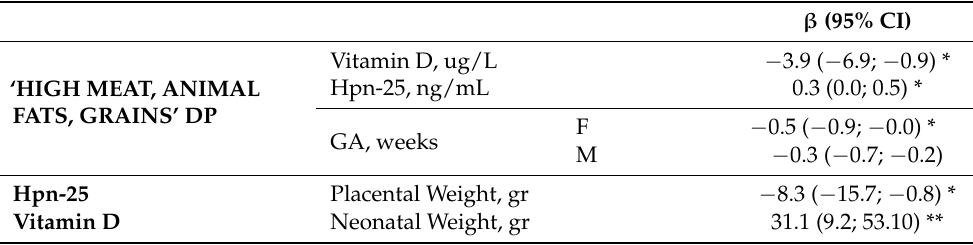
Table 4. Multivariate analysis of the associations between maternal dietary patterns, biomarkers and delivery outcomes in the total study